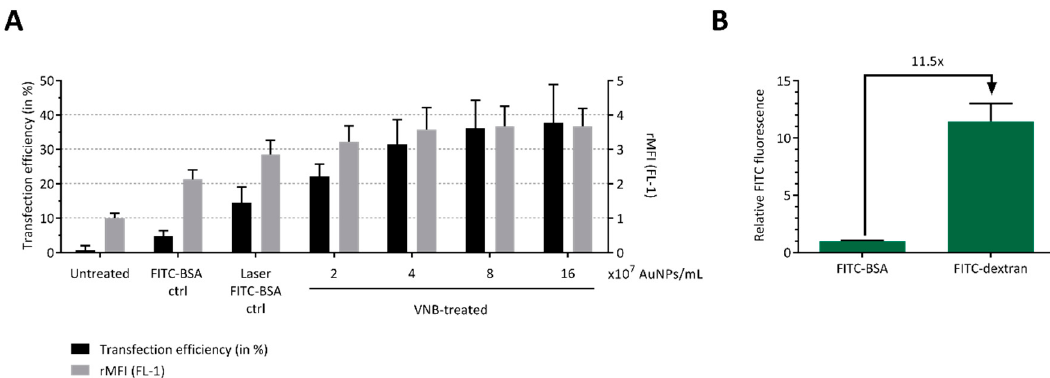
Figure 3. Delivery of FITC-BSA to B16 tumor cells by VNB photoporation. B16 cells were transfected with FITC-BSA (at 2 mg / mL) after incubation with di ff erent concentrations of AuNPs. Untreated cells, cells incubated with AuNPs and FITC-BSA, and cells treated only with laser pulses (without AuNPs) were included as controls. ( A ) FITC-BSA transfection e ffi ciency, as determined by flow cytometry ( n = 3, independent experiments). ( B ) Relative FITC fluorescence of solutions of FITC-BSA (66.5 kDa) and FITC-dextran 70 kDa, measured by fluorimetry at an equal mass concentration of 1 mg / mL ( n = 3, independent experiments).